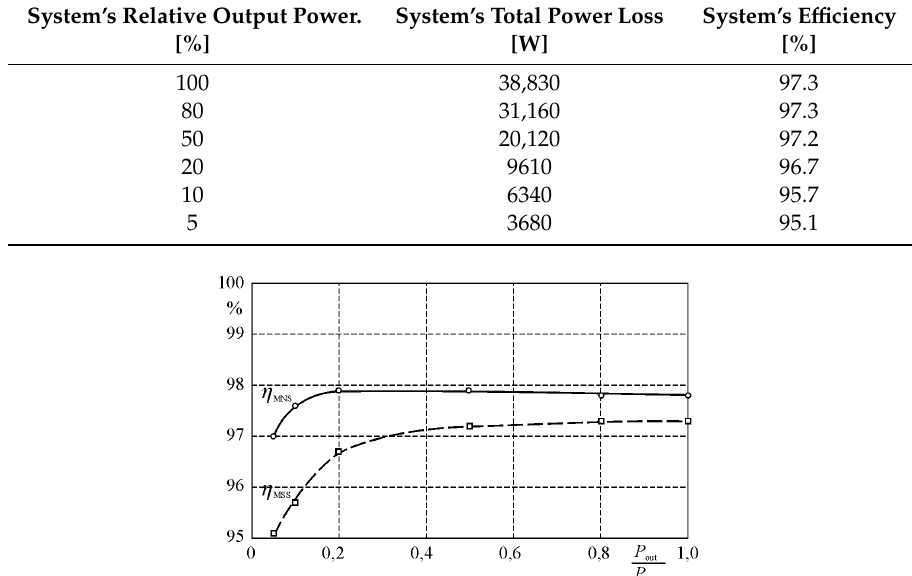
Figure 12. Efficiency of MNS and MSS vs. system’s relative output power. Figure 12. E ffi ciency of MNS and MSS vs. system’s relative output